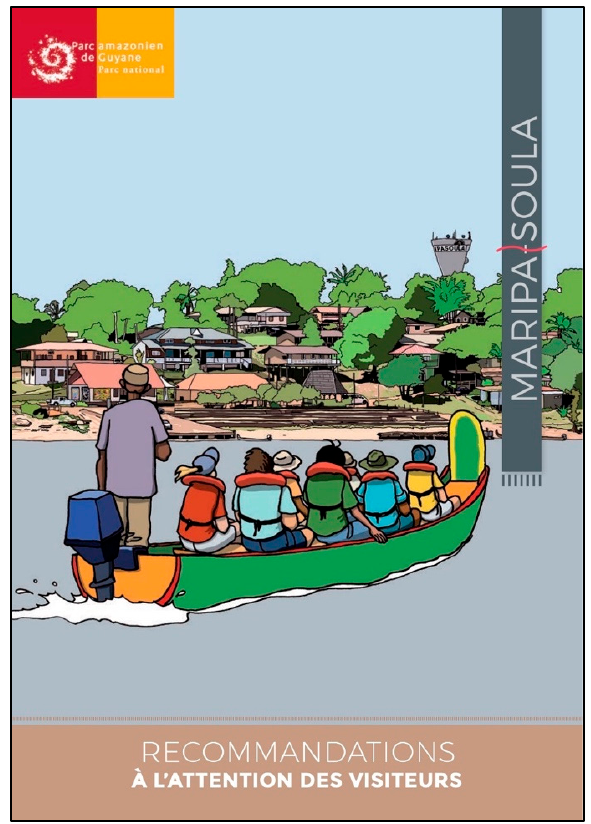
Figure 6. Guide to good conduct for visitors (Source: Guiana Amazonian Park).